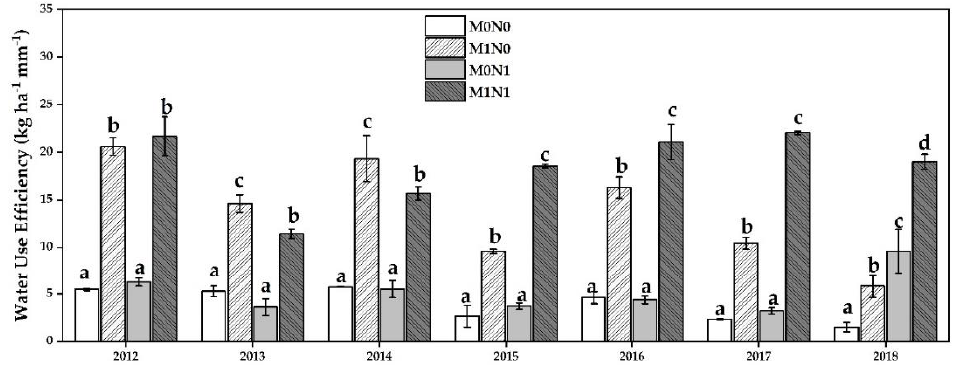
Figure 5. Water use efficiency of each treatment from 2012–2018. M0N0—cultivation without film mulching and N application; M1N0—cultivation with film mulching but without N application; M0N1—cultivation without film mulching but with N application; M1N1—cultivation with film mulching and N application. The different lowercase letters indicate significant difference at p < 0.05.